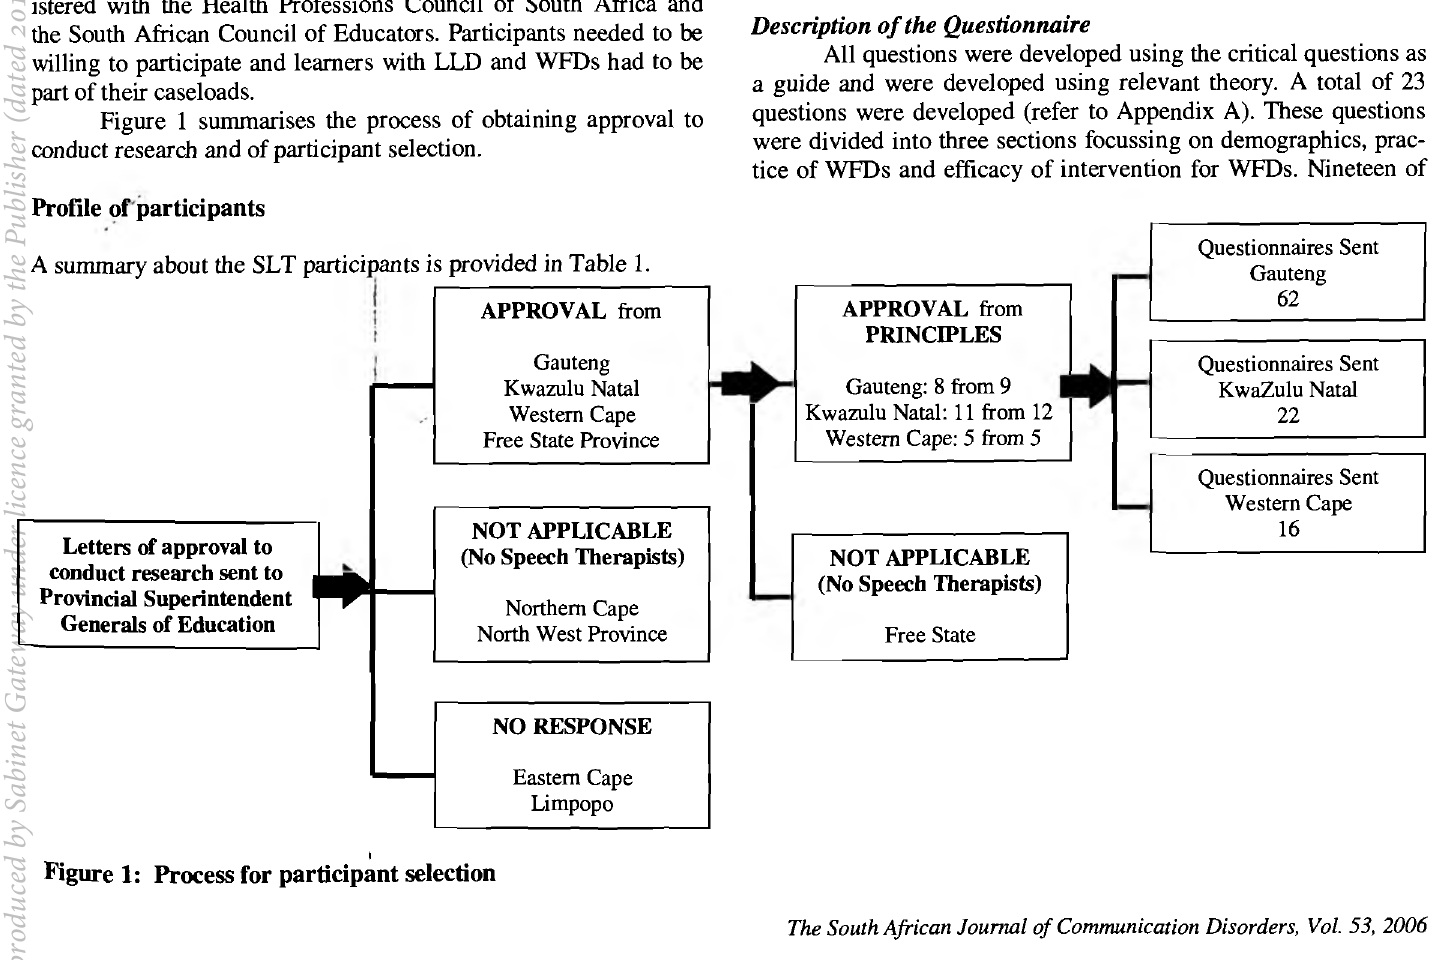
Figure 1: Process for participant